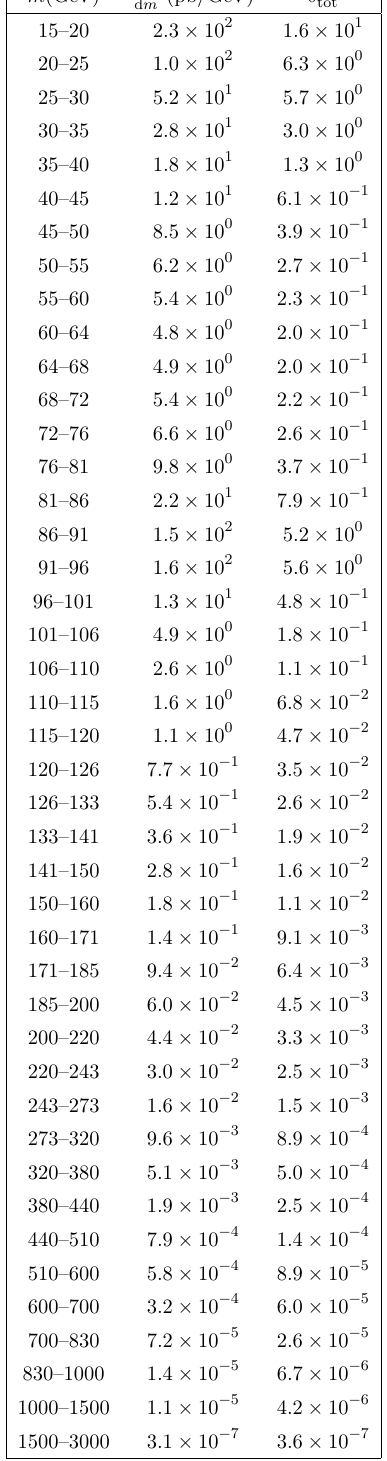
Table 7 . Summary of the combined values of d (cid:27)= d m (pb/GeV) using the results from both the dimuon and dielectron channels. Here, (cid:14) is the quadratic sum of the statistical, experimental and tot theoretical